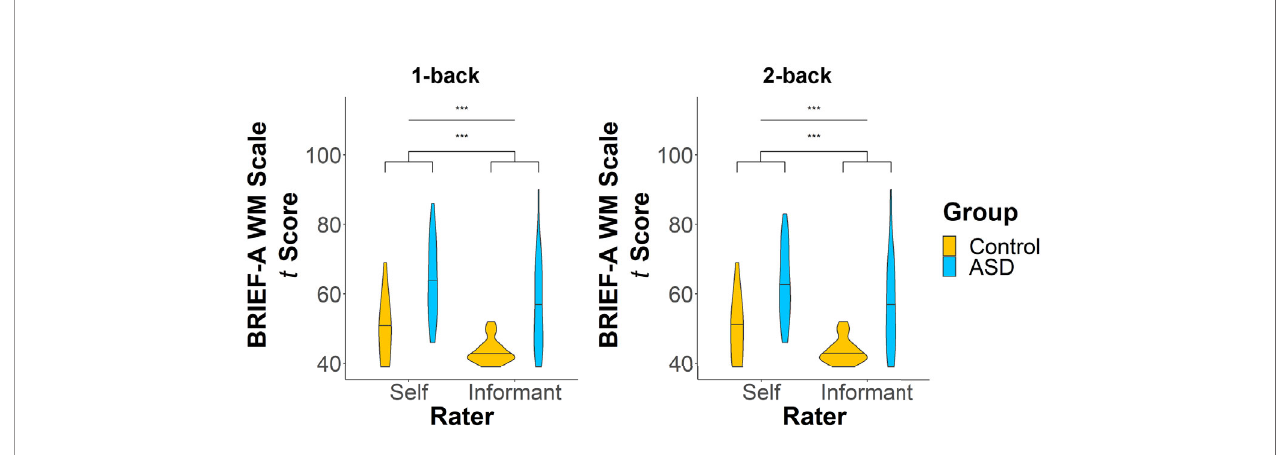
FIGURE 2 | T scores on the working memory (WM) scale of the BRIEF-A for the 1-back (left panel) and 2-back (right panel) samples. There were signi fi cant main effects of both group and rater on WM scores. *** p < 0.001.